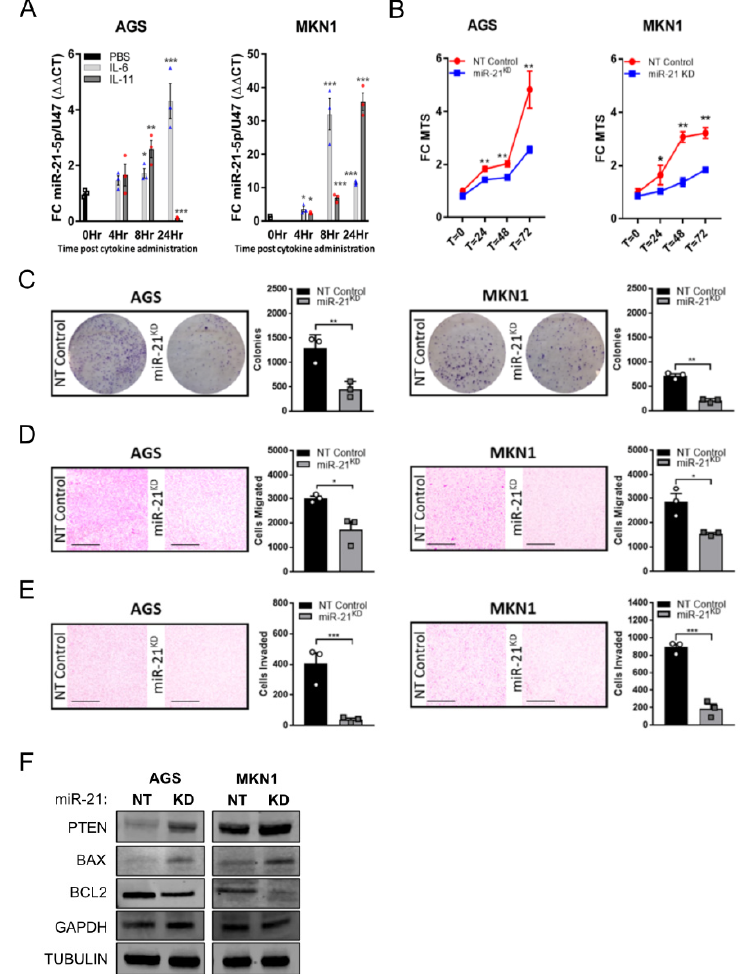
Figure 3. Inhibition of miR-21 attenuates the tumorigenic characteristics of human gastric cancer cells in vitro. ( A ) qRT-PCR TaqMan analysis of miR-21-5p expression in the human gastric cancer cell lines AGS and MKN1 following stimulation with IL-6 or IL-11 for 0, 4, 8 or 24 h. The individual circular, triangular and square data points represent the average values of technical triplicates normalized against the expression of the U47 housekeeping gene. ( B ) MTS proliferation assay of the human GC cell lines AGS and MKN1, either expressing an miR-21 KD construct or as their naïve (NT control) counterparts. The MTS-specific absorbance at 490 nm was expressed relative to the signal at the time of seeding the cells. ( C ) Clonogenic growth assays of AGS and MKN1 cells described in ( B ). The photographs show cell clones in a 100-mm diameter culture dish 10 days after seeding and stained with Crystal Violet. ( D ) Cell migration assays of AGS and MKN1 cells described in ( B ) with representative photographs of the lower side of a transwell 24 h after seeding. ( E ) Cell invasion assays of AGS and MKN1 cells described in ( B ) with presentative photographs of the lower side of a transwell 72 h after seeding. ( F ) Immunoblot analysis for miR-21 targets in AGS and MKN1 cells described in ( B ) using GAPDH and α -TUBULIN as loading controls. Each symbol represents a data point from one of n = 3 experiments, and the data are depicted as the mean ± SEM. * p < 0.05; ** p < 0.01; *** p < 0.001. Scale bar = 200 µm.